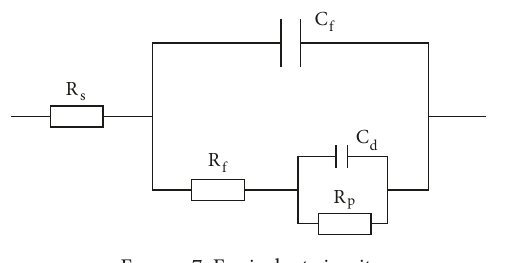
Figure 7: Equivalent circuit.